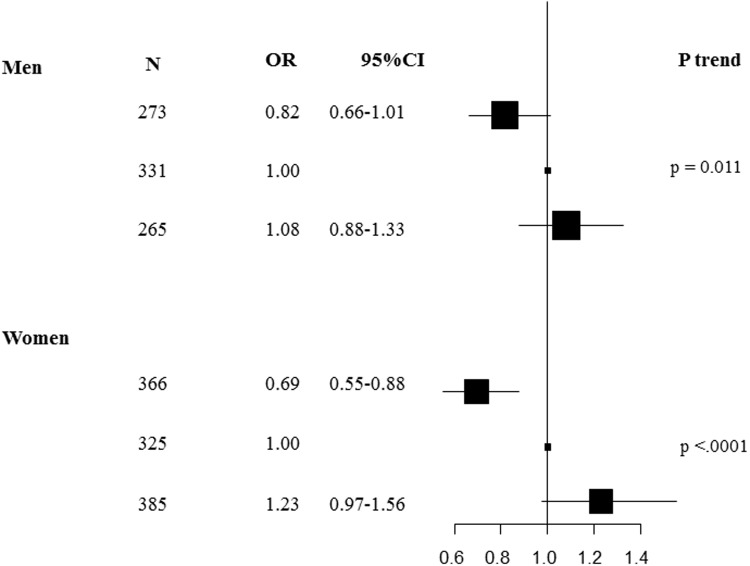
The associations between plasma phospholipid fatty acids and percent of weight change at 5 years were investigated using a multinomial logistic regression model.The percent of weight change at 5 years was estimated as (weightat 5 years minus weight at baseline/weight at baseline)*100, and expressed as a percentage. Weight change during the follow-up was categorized according to tertiles considering the middle category as the reference category (i.e. stable weight at 5 years in %, -1.59;2.83%). The highest tertile (3, weight gain in %, >2.83%) and the lowest (1, weight loss in %, <-1.59%) were compared to the reference category. Exposure variables (fatty acid concentrations 2 log-transformed) were modeled as continuous variables. The model was adjusted by length of follow-up, age, energy and alcohol intakes, smoking status, physical activity, and region. Analyses were carried out for women and men separately.